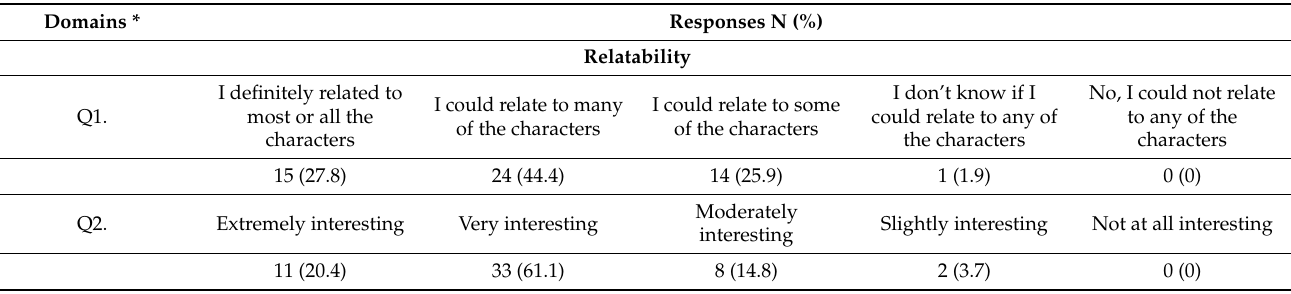
Table 3. Acceptability Measure